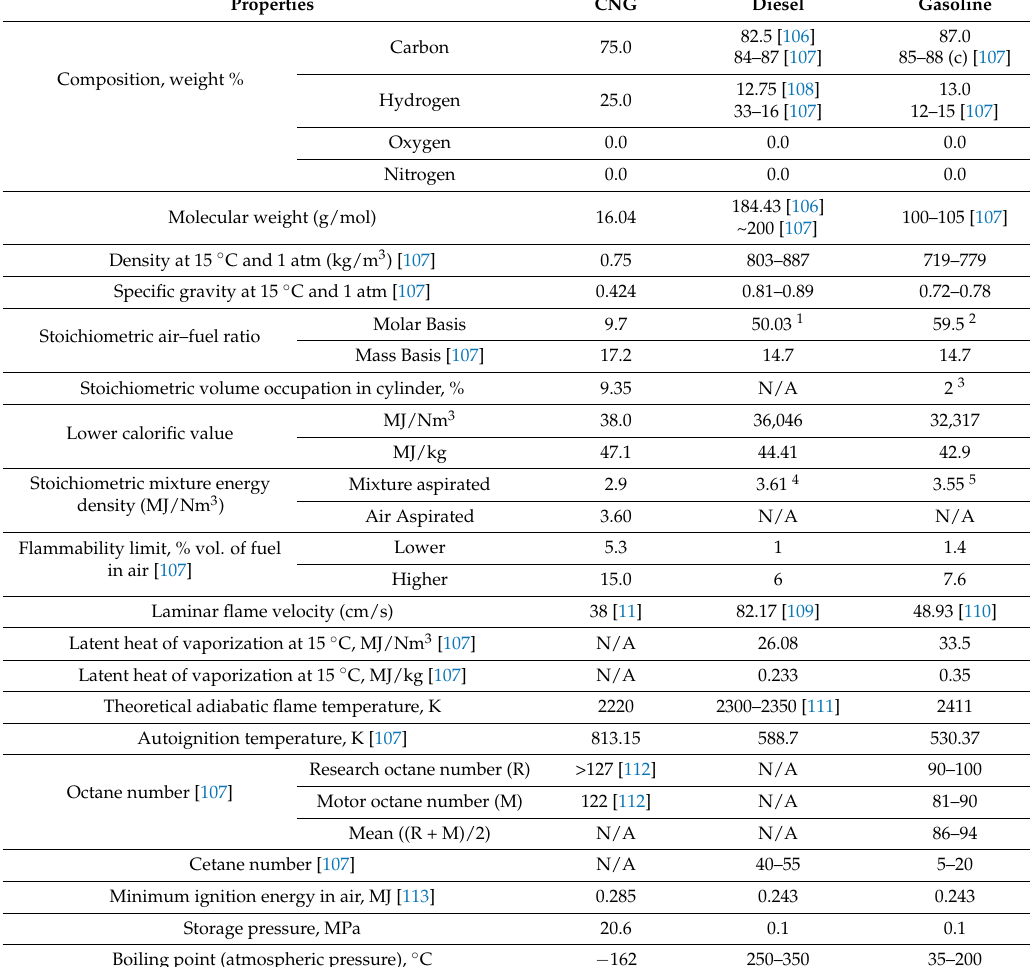
Table 7. Combustion and physical properties of compressed natural gas (CNG), diesel, and